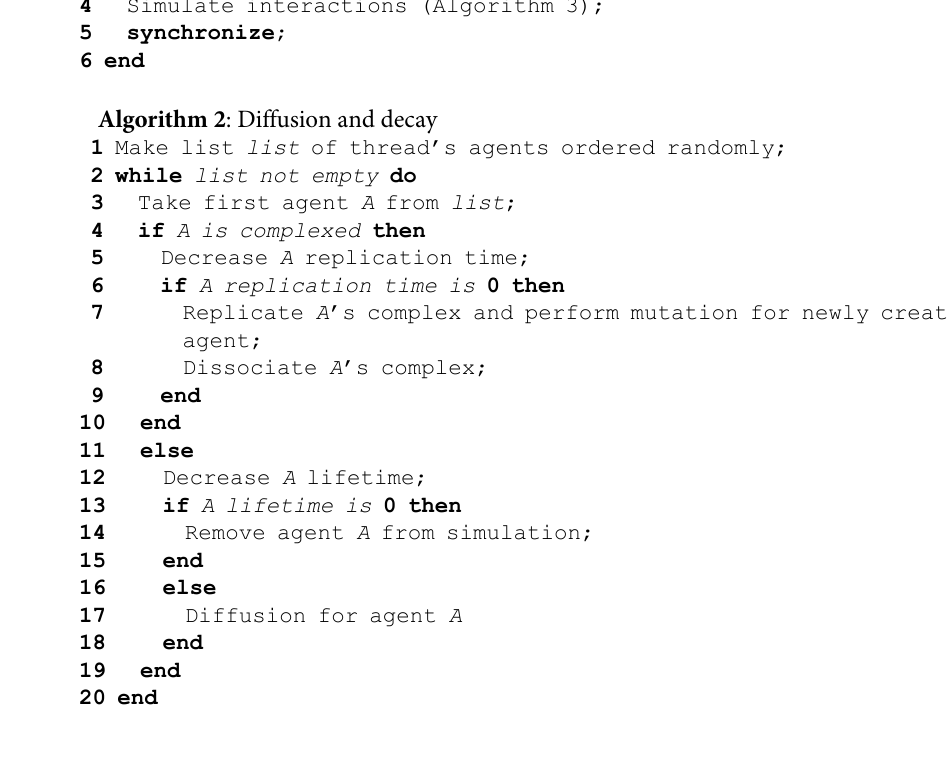
Algorithm 2 : Diffusion and